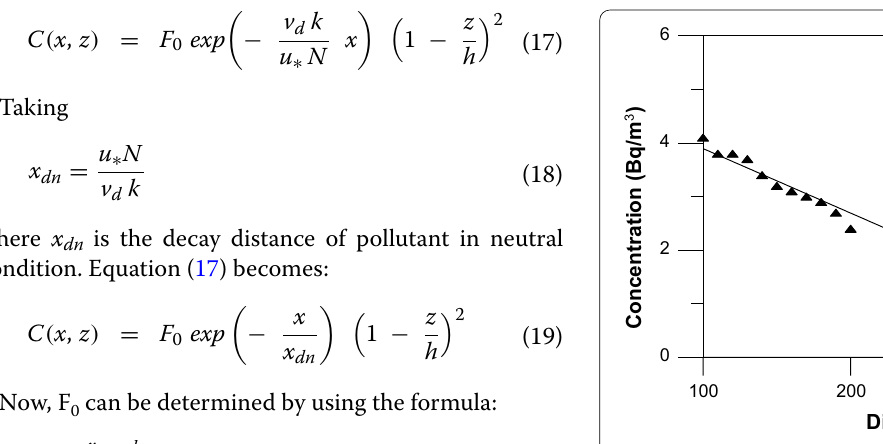
Fig. 2 Diagram of the concentration of (I 131 ) via the downwind